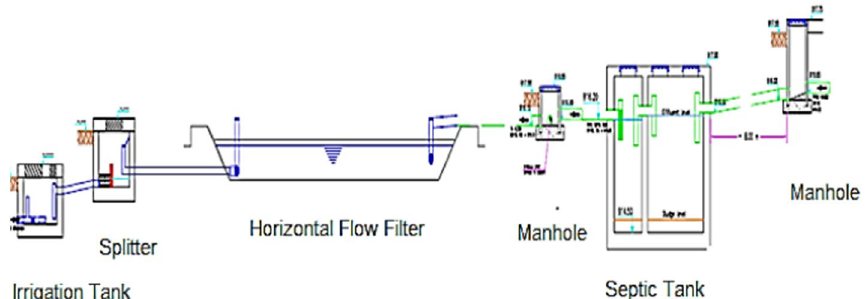
Fig. 1 A schematic diagram shows the configuration of the decentralized wastewater treat- ment plant